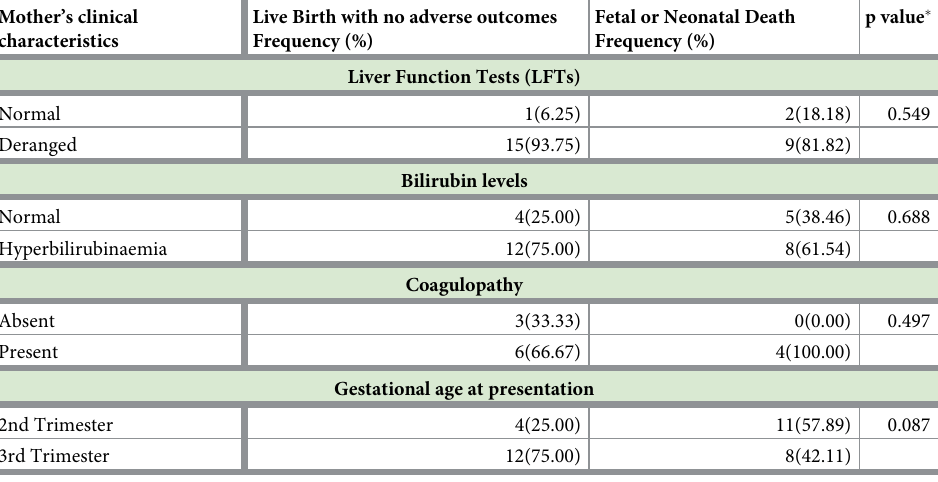
Table 7. Relationship between maternal clinical characteristics and adverse fetal